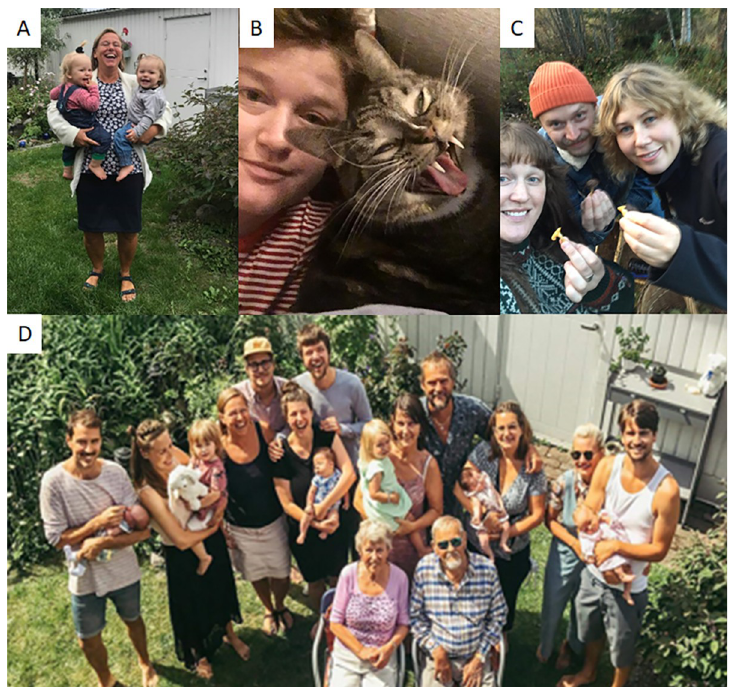
Fig 5. A. With grandchildren: “They are such joy!” B. Lady with cat: “Cuddling with my cat is like receiving unconditional love” C. In the forest with friends: “Being outdoors with friends is lovely” D. Picture of relatives: “My family–rewarding and